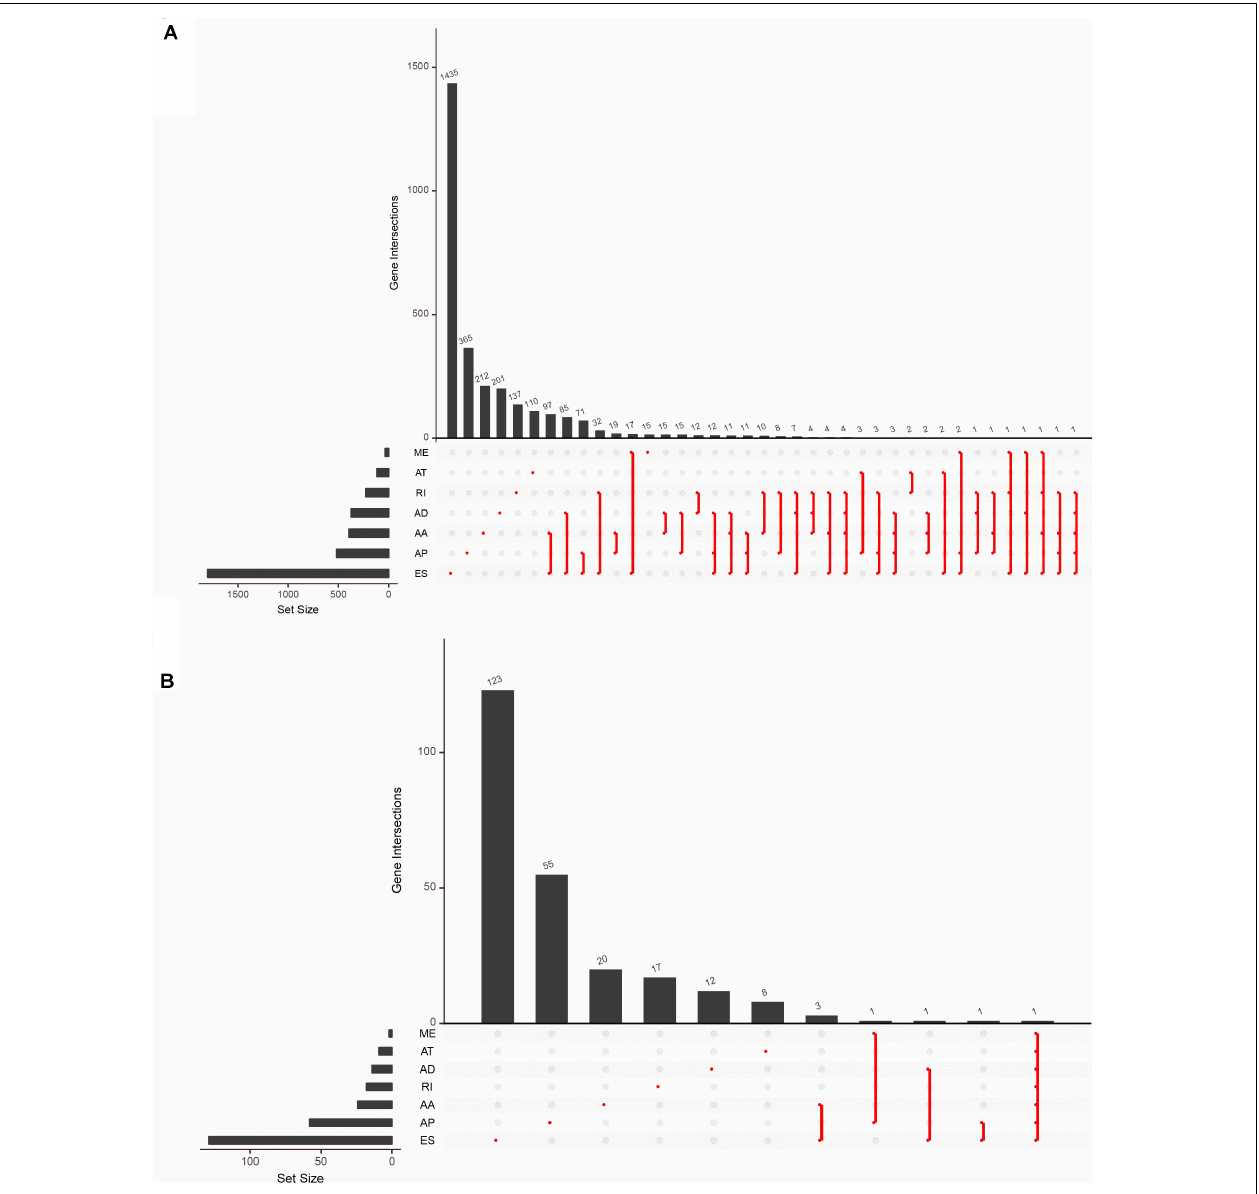
FIGURE 2 | Overview of dataset. (A) The Upset plots of seven types of alternative splicing events and their parent genes. (B) The Upset plots of seven types of prognosis-related alternative splicing events and their parent genes. The lower part of each plot describes the permutations of the alternative splicing events; for each circumstance, the alternative splicing event is included if its corresponding place is filled with a red dot. The upper part of the plot represents the number of genes for each circumstance. AA, alternate acceptor; AD, alternate donor; AP, alternate promoter; AT, alternate terminator; ES, exon skip; ME, mutually exclusive exons; RI, retained